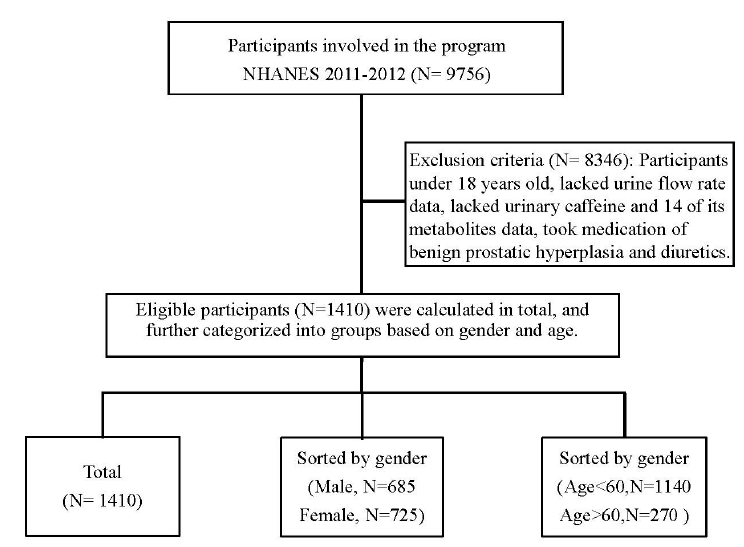
Figure 1. Flow chart of participant recruitment.